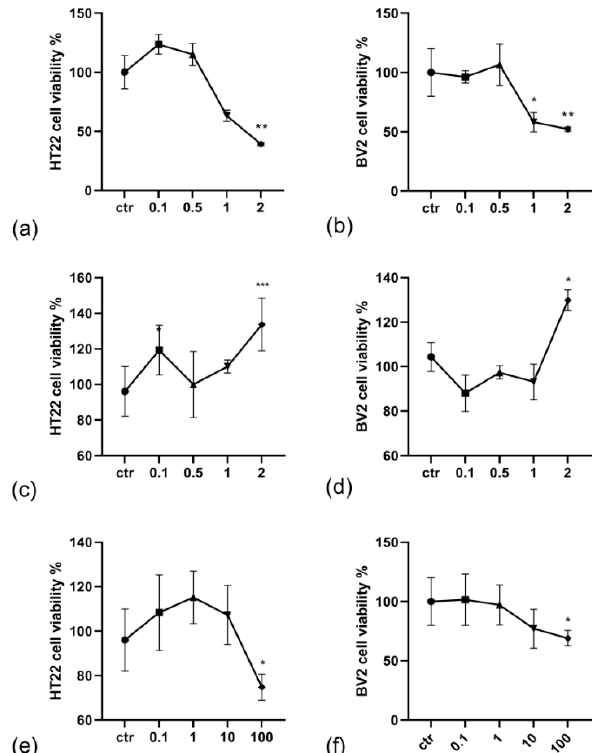
Figure 6. The effects of active principles on viability of HT22 and BV2 cells. HT22 ( a , c , e ) and HT22 and BV2 cells ( b , d , f ) were treated with increasing concentrations of α -lipoic acid ( a , b : 0.1, 0.5, 1, 2), N-acetyl-cysteine ( c , d : 0.1, 0.5, 1, 2) and propentofylline ( e , f : 0.1, 1, 10, 100). All the active priciples concentrations are expressed in mM. The graphs show the mean + SEM of three independent experiments performed in triplicate. The statistically significant differences between experimental conditions and untreated control cells are shown by asterisks (* p < 0.01; ** p < 0.01; *** p < 0.001). Table 1. Fold change ± SEM of inflammatory marker genes in HT22 compared with non-inflamed cells. The statistically significant differences between treated and untreated control cells are shown by asterisks (* p < 0.05, ** p < 0.01) and bold type. HT22 Upregulated Ctr α -lipoic acid